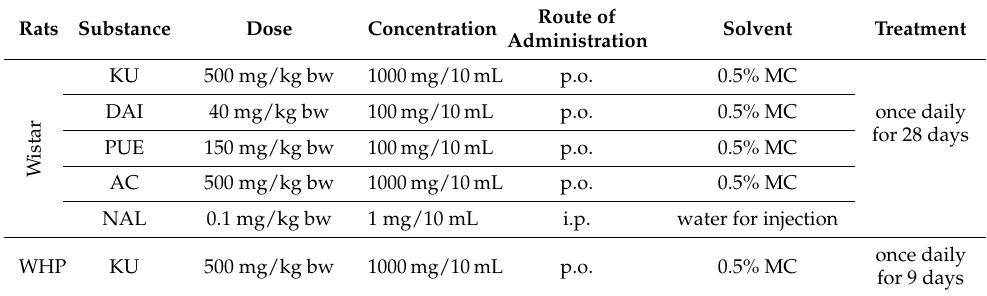
Table 2. Doses, concentrations and routes of administration for individual substances in a suitable